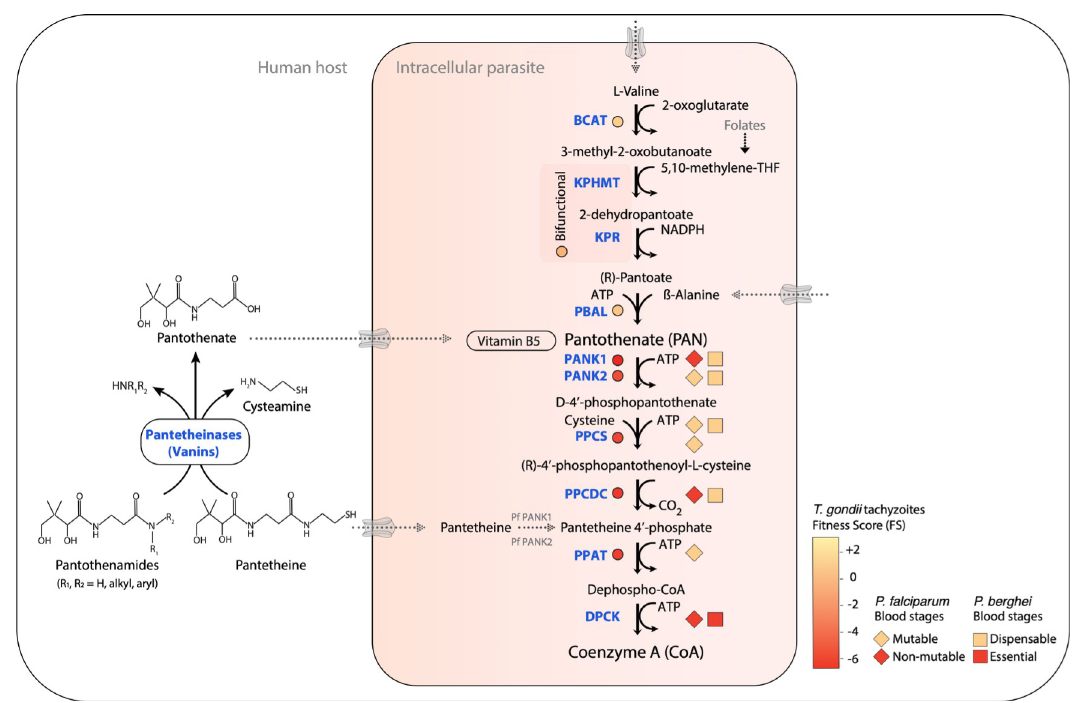
Fig 1. Pan and CoA biosynthesis pathways and the predicted essentiality in T . gondii , P . berghei , and P . falciparum . Phenotypic data for T . gondii tachyzoites and P . berghei and P . falciparum asexual blood stages are derived from Sidik and colleagues [20], Bushell and colleagues [21], and Zhang and colleagues [22], respectively. Since the essentiality data for each of the species ( T . gondii , P . berghei , and P . falciparum ) were obtained using different genetic approaches, the most representative forms are displayed. The FS for T . gondii (circles) is an experimentally observed measure (ranging from − 6.9 to +3 for the fitness cost associated with the disruption of a given gene for parasite survival. Fitness-conferring genes display a lower FS and dispensable genes display a higher FS [20]. Phenotypic data for P . falciparum genes based on their MIS, which estimates the potential mutability of a gene, are represented as diamonds [22]. For P . berghei , a gene is indicated as dispensable or essential based on the relative growth rate observed upon genetic disruption within the asexual blood stage (squares) [21]. Dashed lines represent putative routes. Pantothenamides and pantetheine can further be hydrolyzed into Pan via the action of host-encoded pantetheinases (vanins) [23]. BCAT, branched-chain amino acid transaminase; CoA, coenzyme A; DPCK, dephospho-CoA kinase; FS, fitness score; KPHMT, ketopantoate hydroxymethyltransferase; KPR, α -ketopantoate reductase; MIS, mutagenesis index score; PBAL, pantoate- β -alanine ligase; Pan, pantothenate; PANK, pantothenate kinase; PPAT, phosphopantetheine adenylyltransferase; PPCDC,